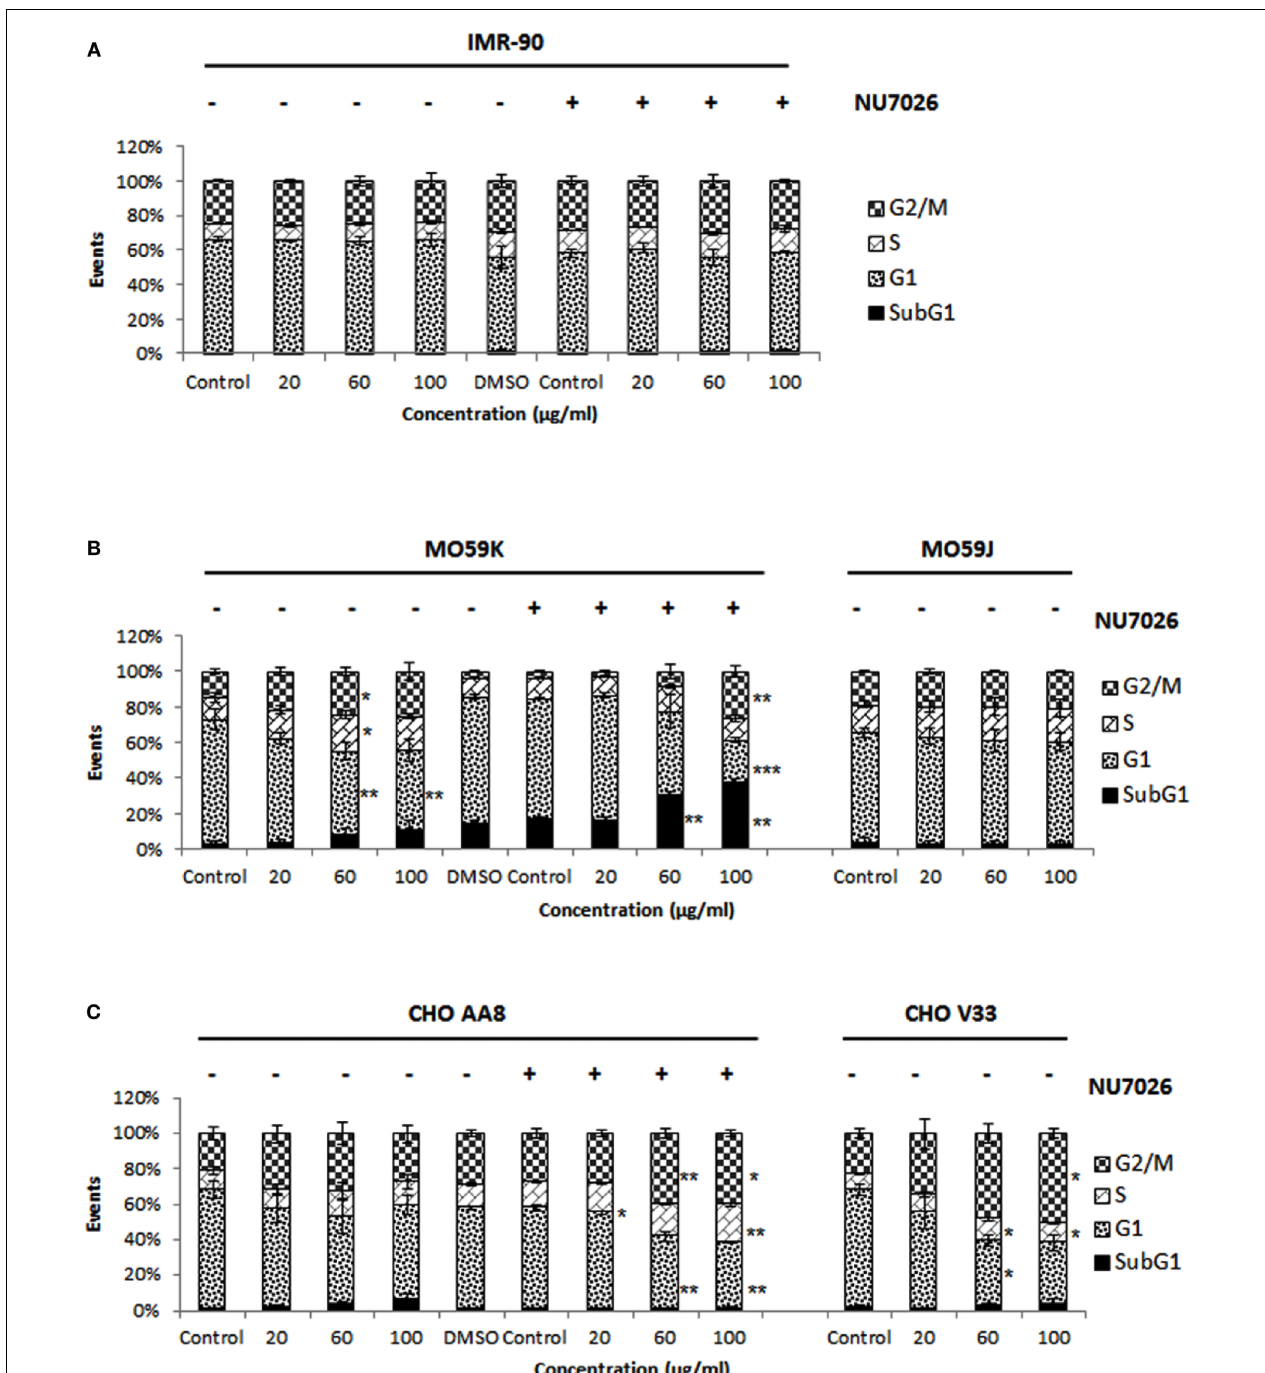
measured by propidium iodide staining. Markers were set at regions of interest (subG1, G1, S, and G2/M), and the percentage of cells (events) under each area was generated using Microsoft